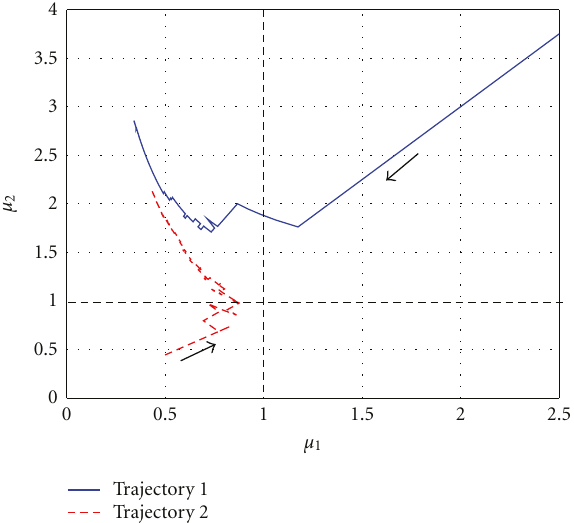
Figure 7: An example of the evolution of aloha-like spectrum access probability when N = 2 and system state is fully observable.